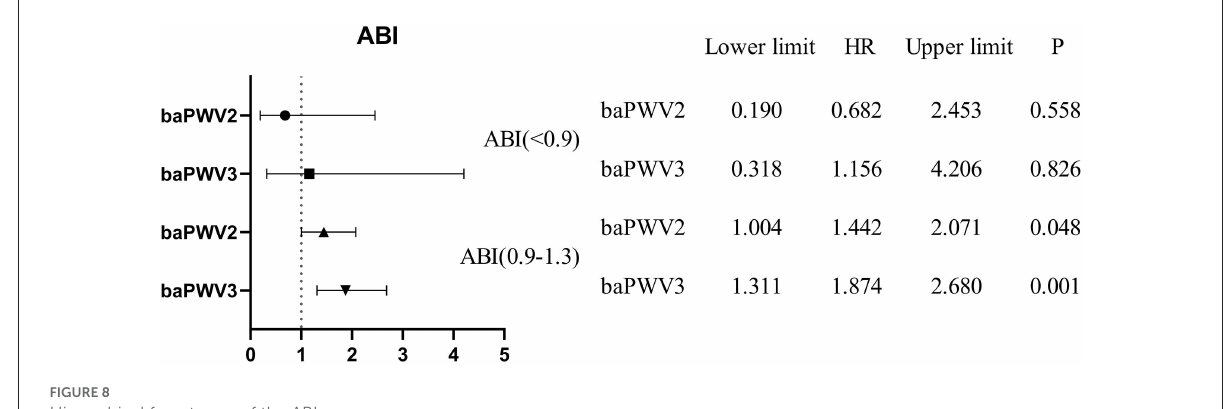
FIGURE8 Hierarchical forest map of the